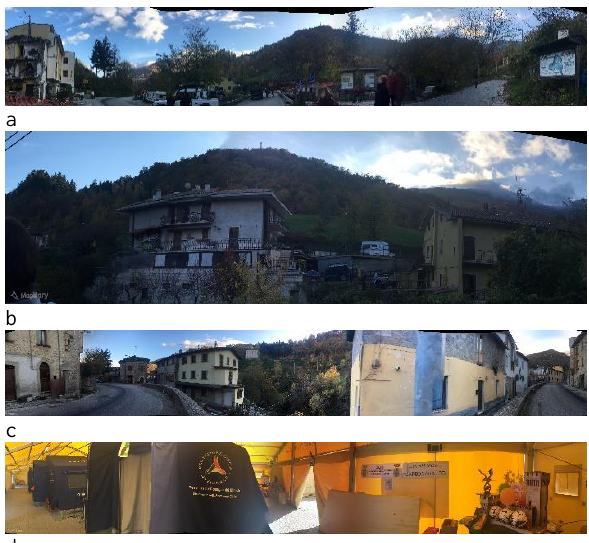
Figure 4. Stitched panoramic images, Arquata del